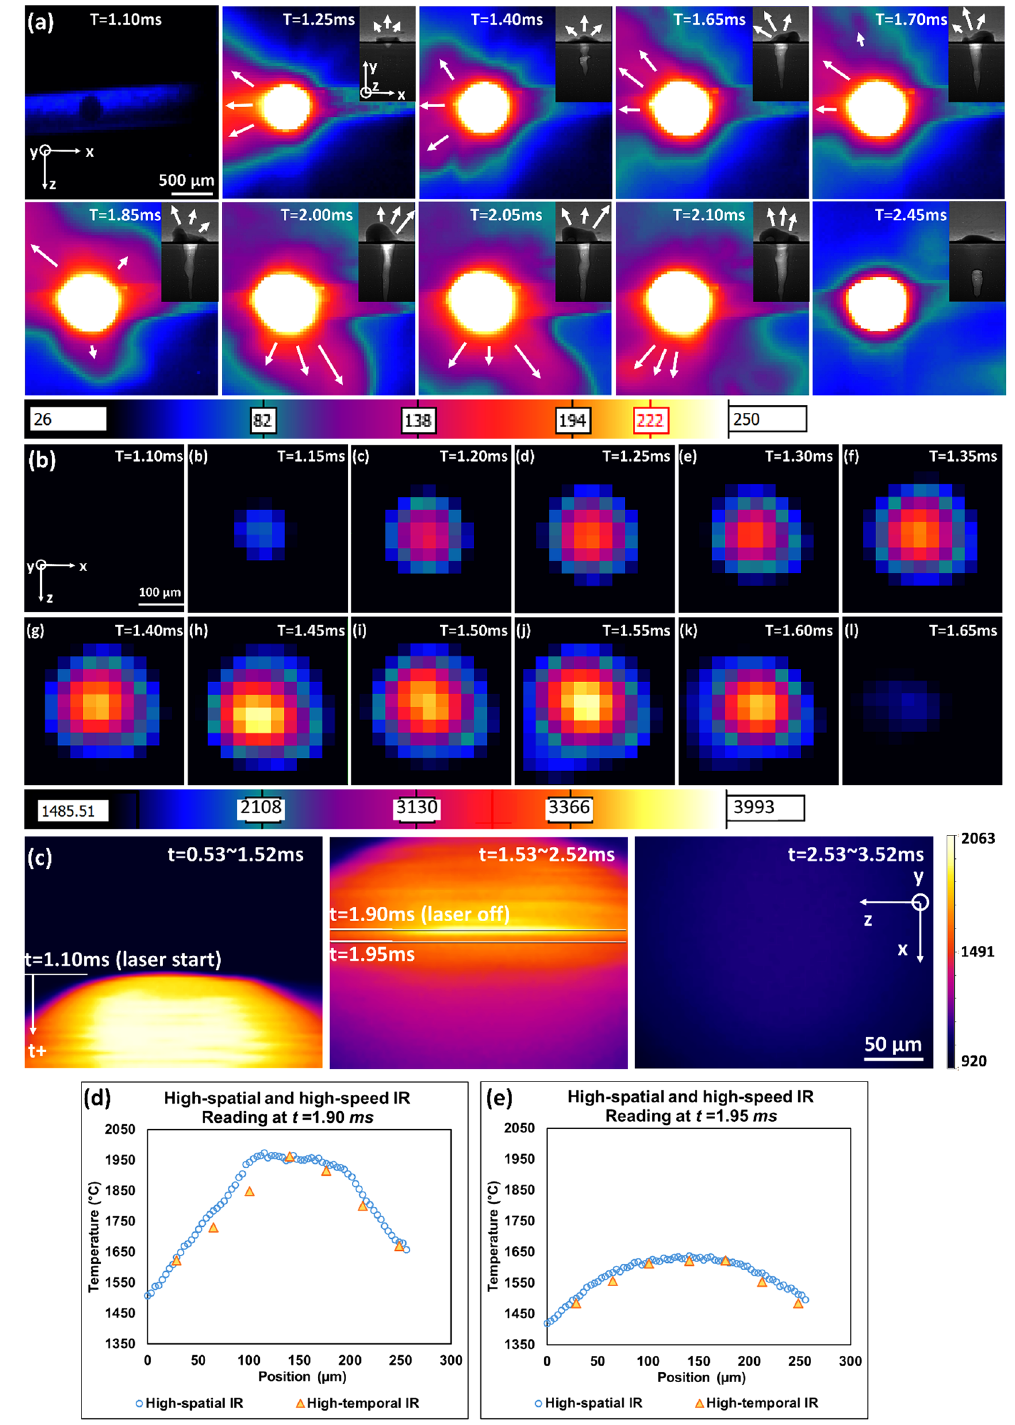
Figure 4. ( a ) Selected high-speed IR with a low-temperature filter showing vapor plume dynamics of Trial #9 (410 SS, 416 W 1 ms), where the dynamics of the vapor plume can be observed. The corresponding X-ray images in the upper right corner share the same scale as the IR images. ( b ) Selected high-speed IR with a high- temperature filter, showing melt pool temperature dynamics of Trial #12 (Ti–6Al–4V, 416 W, 0.5 ms). ( c ) The high-spatial IR observations of Trial #19 (Ti–6Al–4V, 260 W, 0.8 ms). The vertical direction contains both spatial and temporal information due to the camera sensor reading line by line from top to bottom. ( d ) The high-spatial and high-speed IR readings at the same location of t = 1.90 ms. ( e ) The high-spatial and high-speed IR readings at the same location of t = 1.95 ms. (Temperatures all in